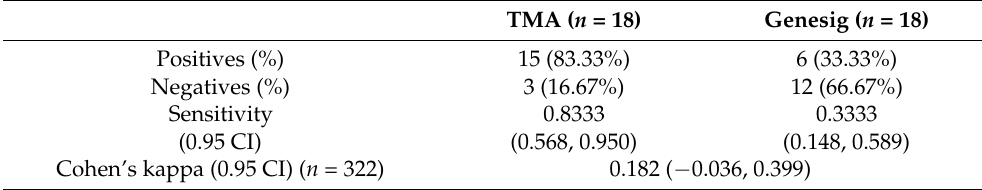
Table 5. Sensitivity of TMA and Genesig real-time PCR of samples with low viral loads (Genesig Ct > 30) after 1:10 pooling.